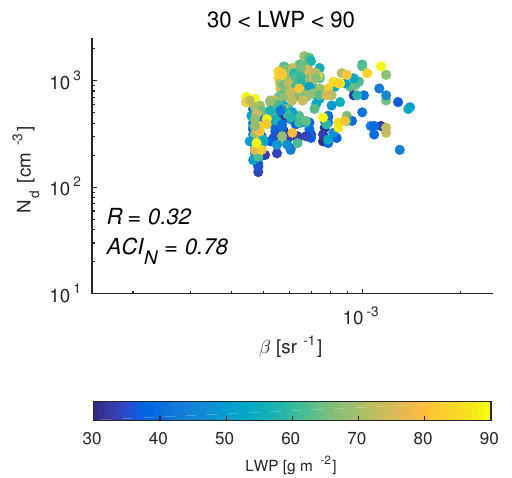
Figure 7. The cloud droplet number concentration, N d , derived from WACR and MWR measurements with Eq. (11) is plotted ver- sus the integrated attenuated backscatter ATB measured by Vaisala CT25K on 3 November 2009. The corresponding value of ACI N (Eq. 7) and the Pearson product-moment correlation coefficient, R , is presented.